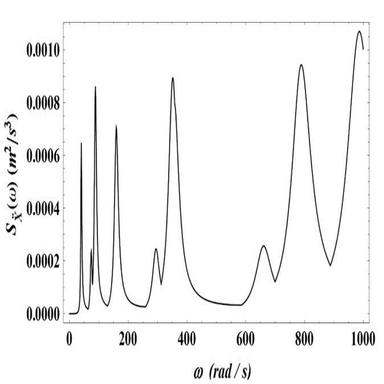
Example of PSD function obtained with the described procedure.